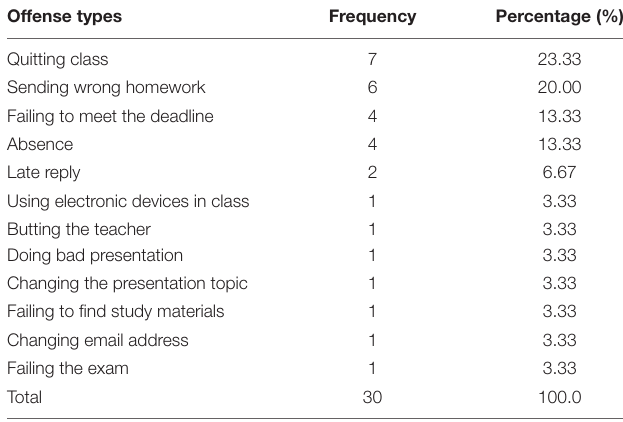
TABLE 2 | Summary of offensive